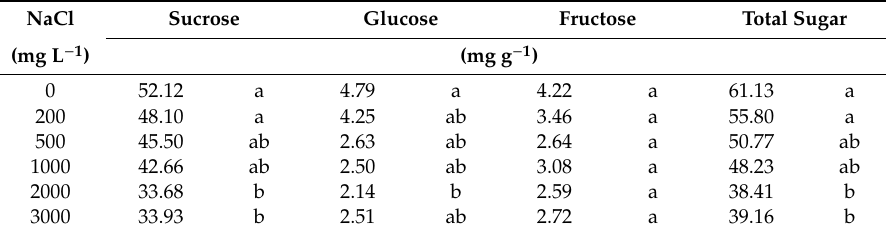
Table 5. E ff ects of NaCl levels in irrigation water on leaf sugar composition.